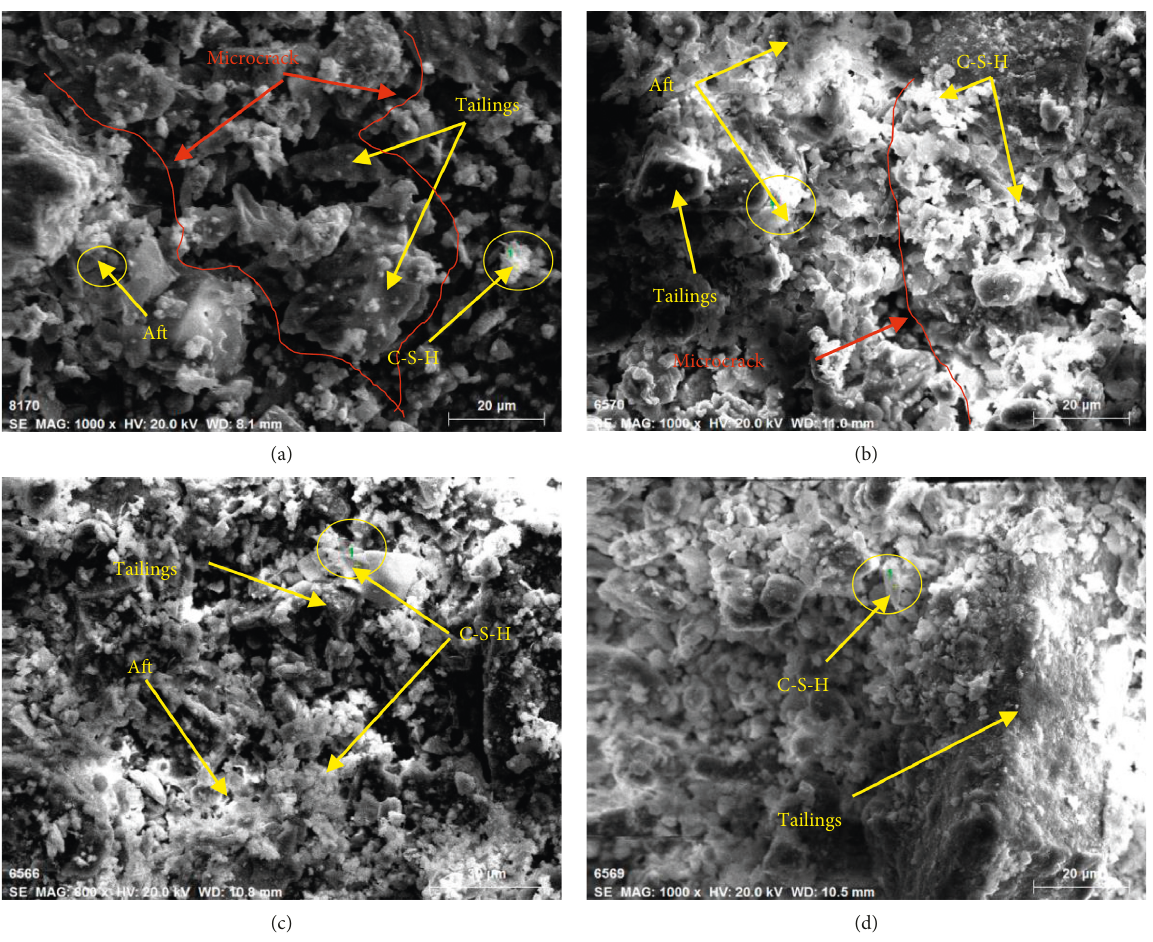
Figure 9: SEM picture of backfill varies relative to temperature and mass concentration (cement dosage at 10%): (a) mass concentration at 74%, 7 days, and 5 ° C; (b) mass concentration at 75%, 7 days, and 5 ° C; (c) mass concentration at 75%, 7 days, and 16 ° C; (d) mass concentration at 75%, 28 days, and 16 °